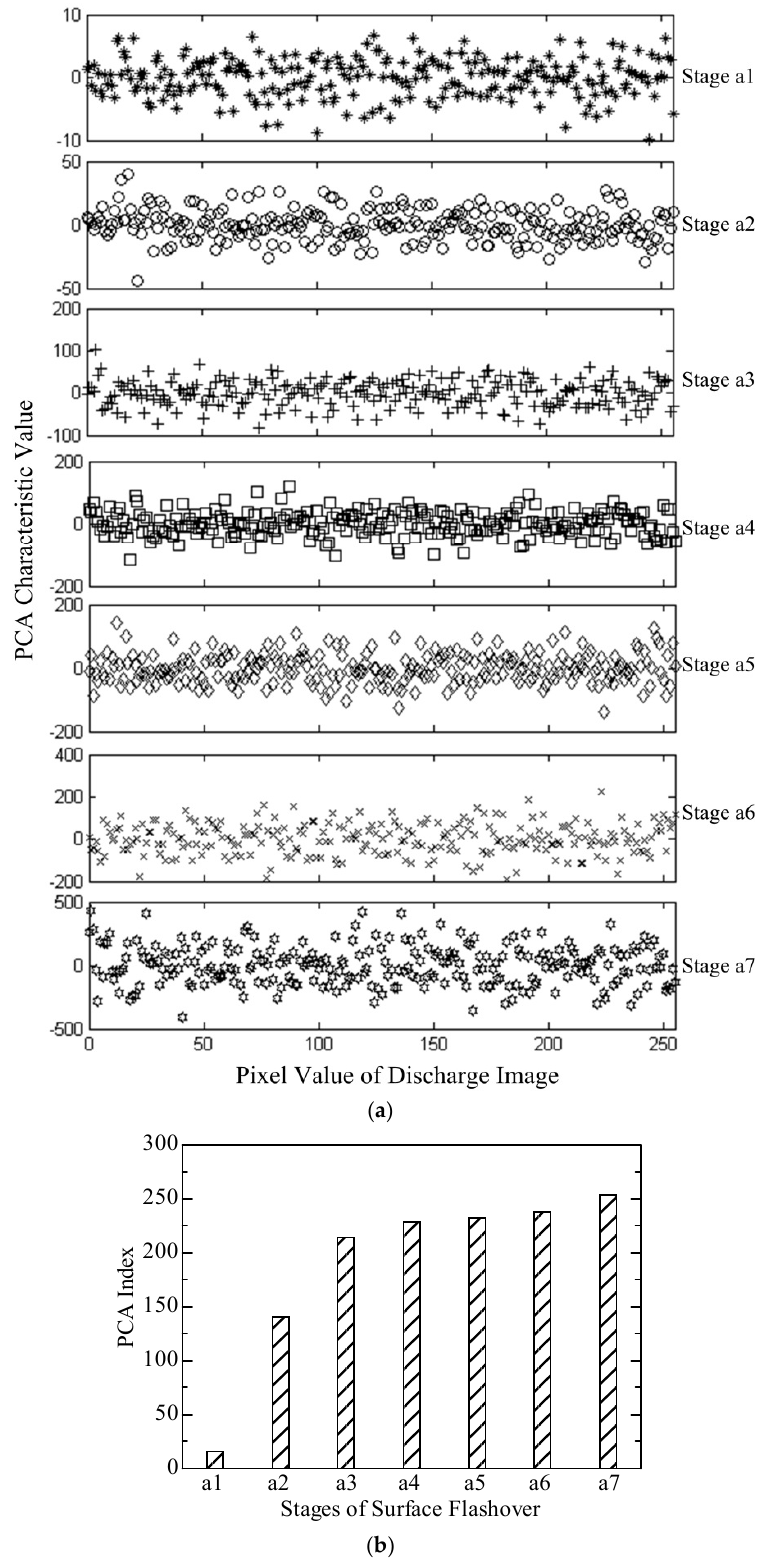
Figure 5. PCA analysis of surface flashover process at different stages in the presence of fine particles. ( a ) PCA characteristic value of surface discharge at different stages; ( b ) PCA classification of discharge characteristics during the propagation of surface discharges to flashover with PCA characteristic value above 6.